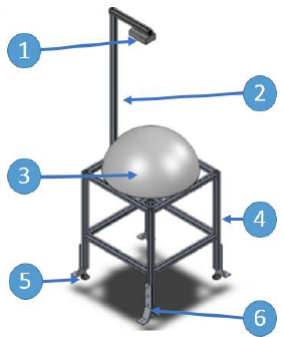
Figure 1. System